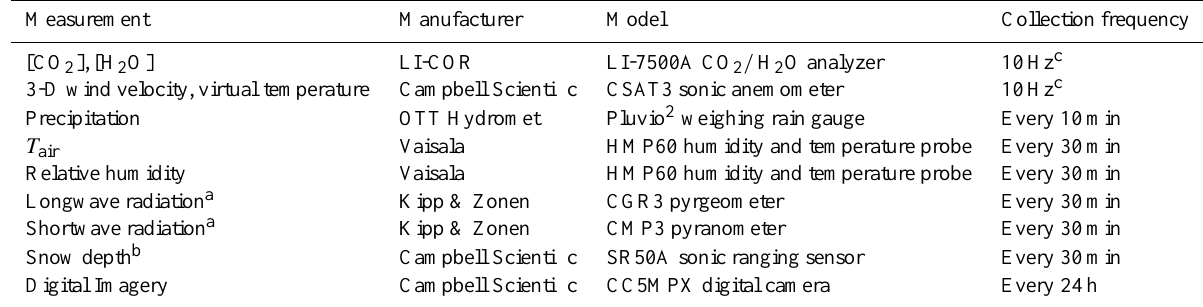
Table 2. Measurements and instrumentation for Tower HOG